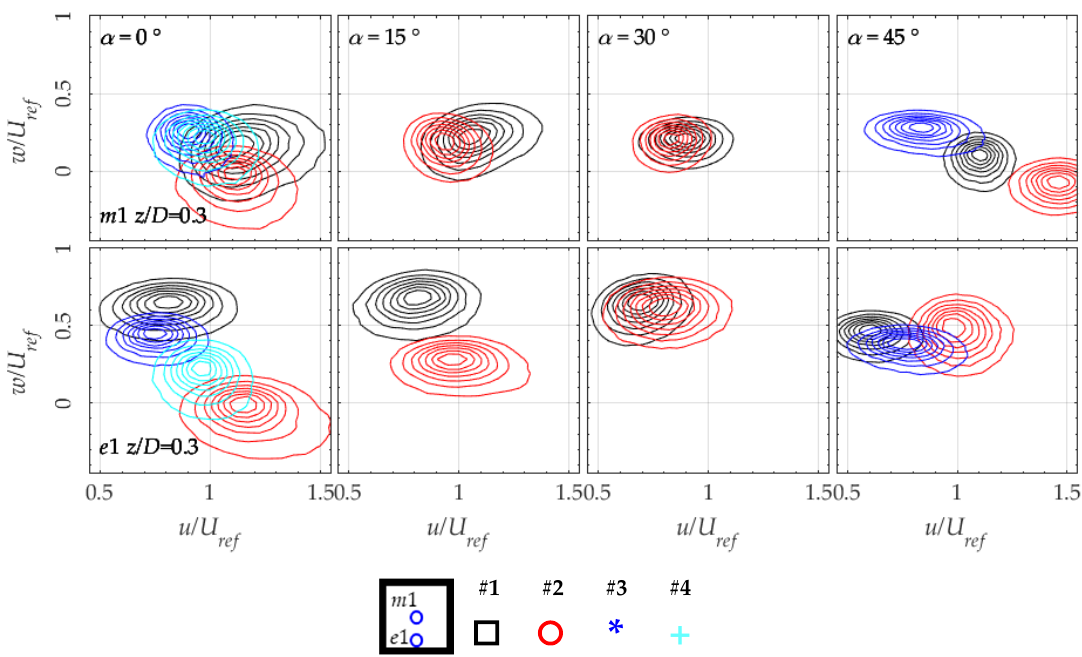
Figure 17. Joint Probability Distribution Function for the along-wind u and vertical w velocity for windward edge e 1 (bottom row) and centre locations m 1 (top row) at the four wind directions (rows).